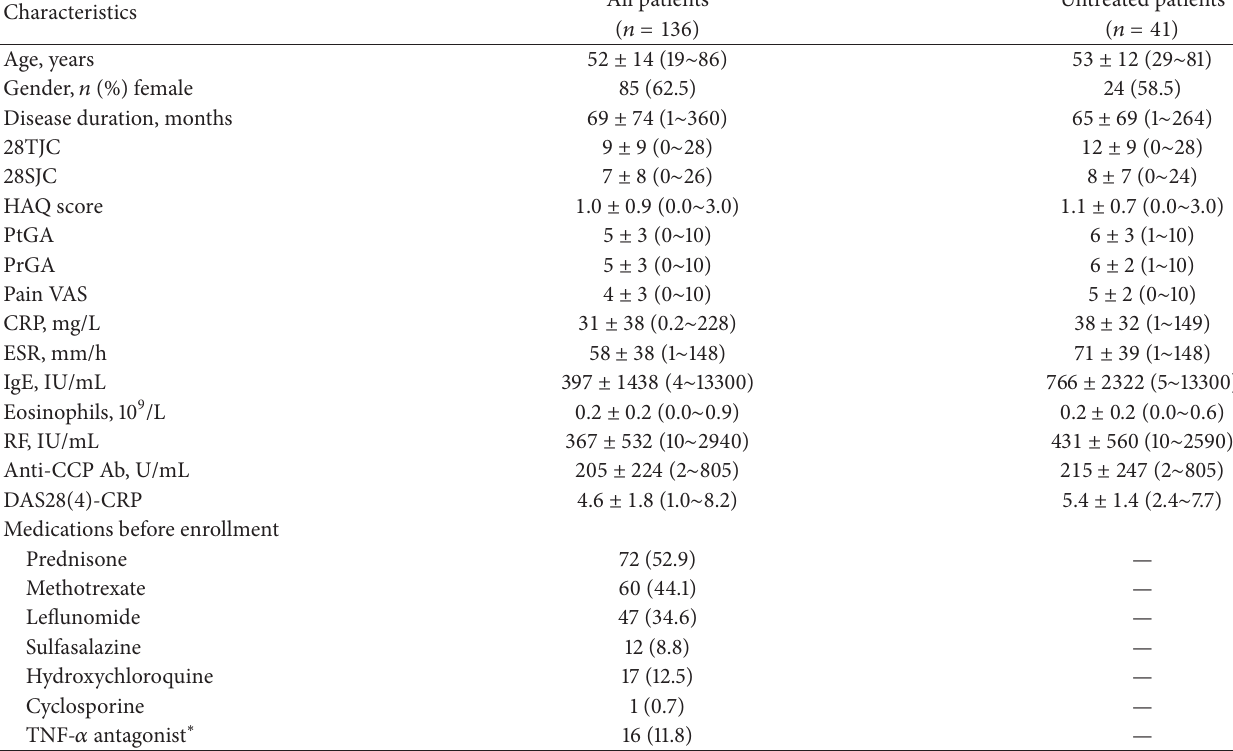
Table 1: Baseline demographic characteristics of all RA patients and untreated RA